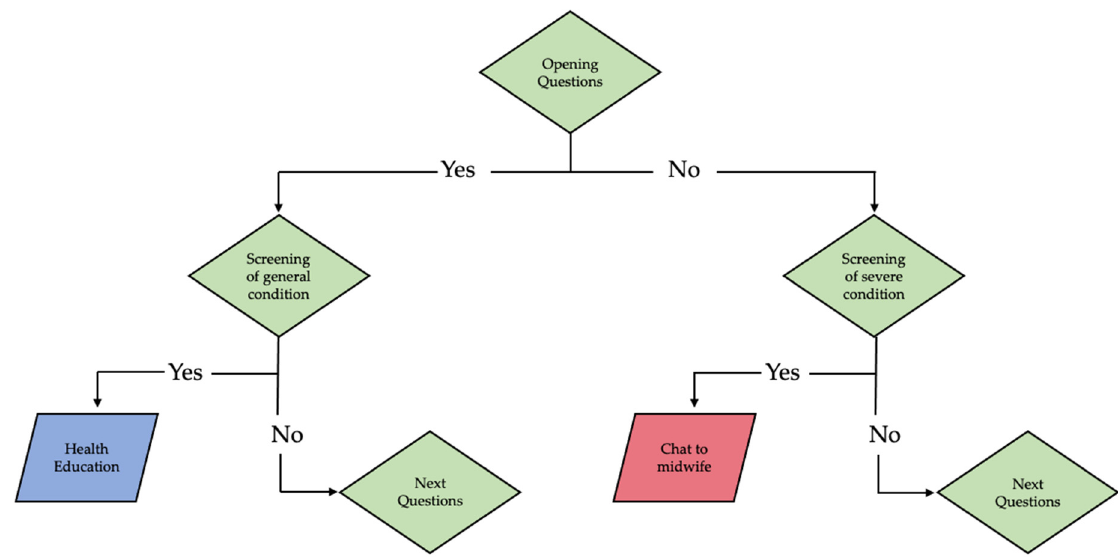
Figure 4. An illustration of the hierarchical rules of a decision tree.